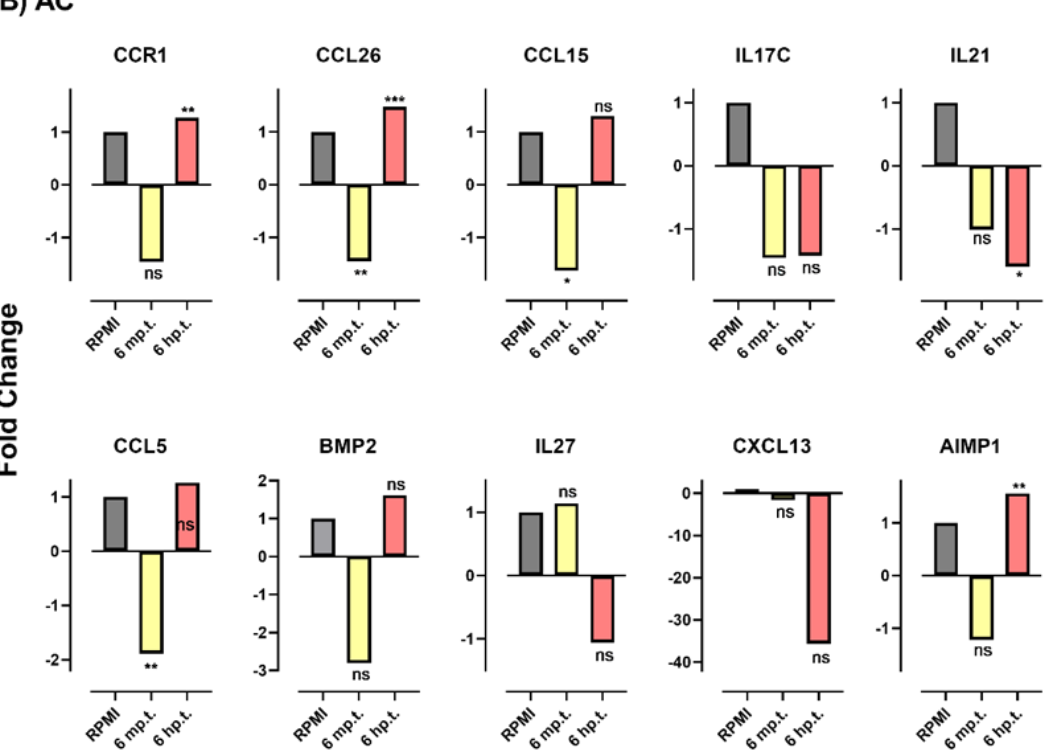
Figure 6. The fold changes of the selected inflammatory genes in herb-treated DENV-2 TL-30 infected T98G cells relative to untreated viral-infected cells. T98G cells were incubated with DENV-2 TL-30 at MOI = 1 for 1 h, and the unbound virus was removed by washing with RMPI to synchronize the replication, then treated with each herb at a concentration of 5 mg/mL or RPMI supplemented with 15% FCS. Cells were collected to determine gene expression level at 6 min and 6 h post-treatment. ( A ) Selected genes for which treatment with Hedyotis diffusa (HD); ( B ) gene expression in Artemisia capillaris (AC) treated samples; * p < 0.05; ** p < 0.01; *** p < 0.001; **** p < 0.0001; and ns indicates a p value of over 0.05 (p > 0.05).